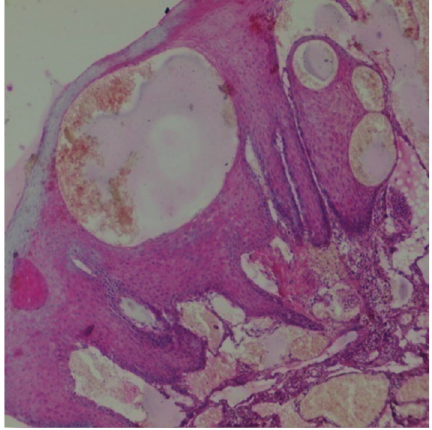
Figure 3: 100x magnification.